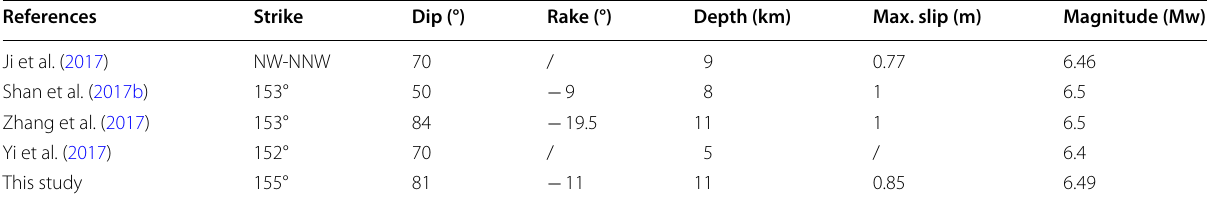
Table 3 Focal mechanism solutions of the Jiuzhaigou earthquake from different